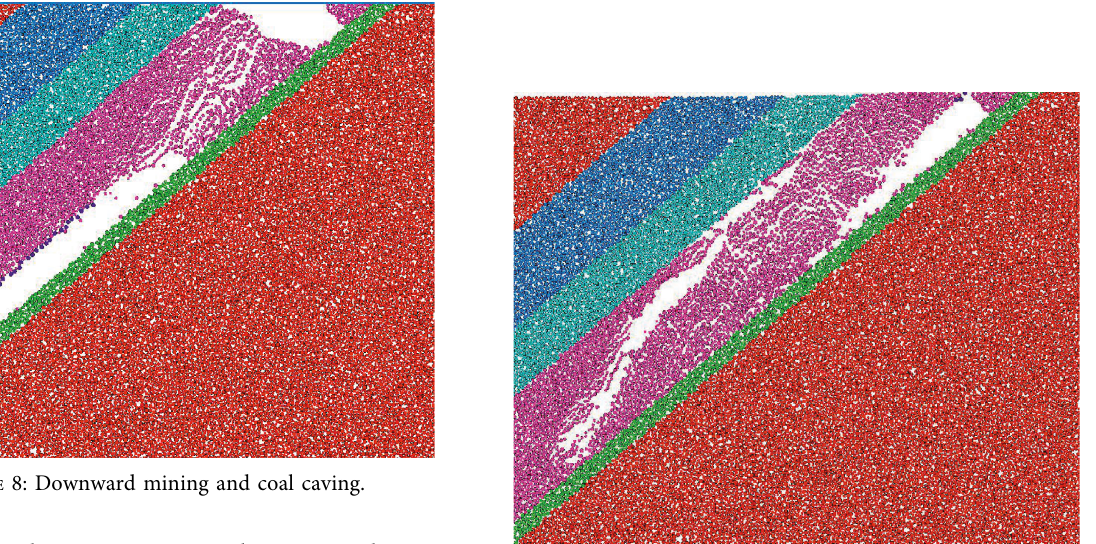
Figure 10: Single-interval coal caving.